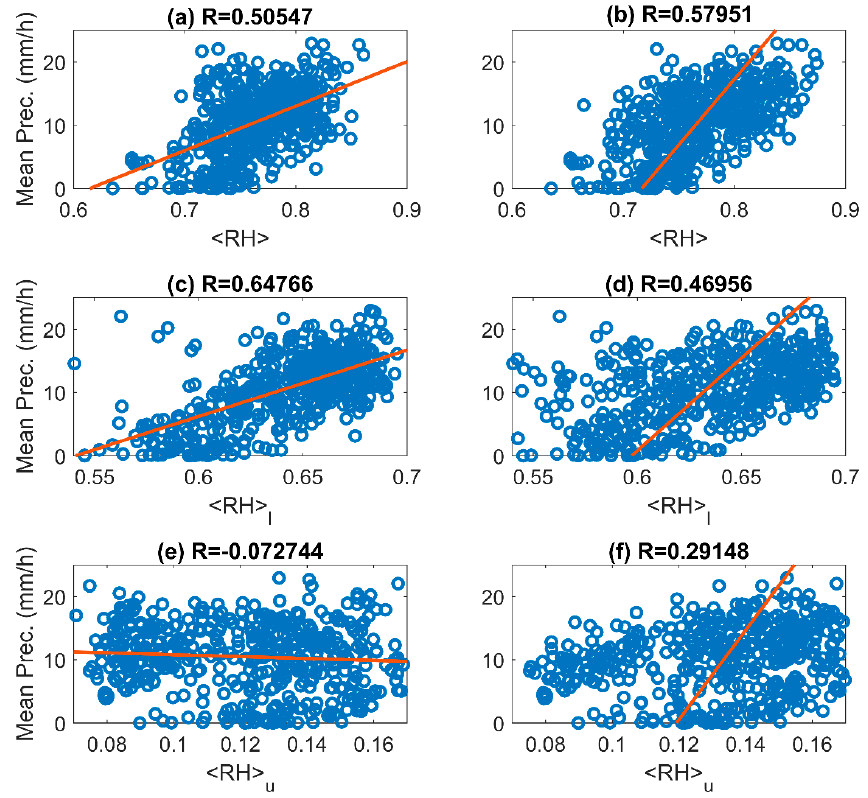
Figure 6. ( Left side) scatter and regression of initial moisture(( a ) <RH>, ( c ) <RH> l , ( e ) <RH> U ) onto the maximum intensity of precipitation. ( Right side) the regression of maximum precipitation onto final moisture (( b ) <RH>, ( d ) <RH> l , ( f ) <RH> U ) (i.e., regression is performed on the inverse of the axes plotted).